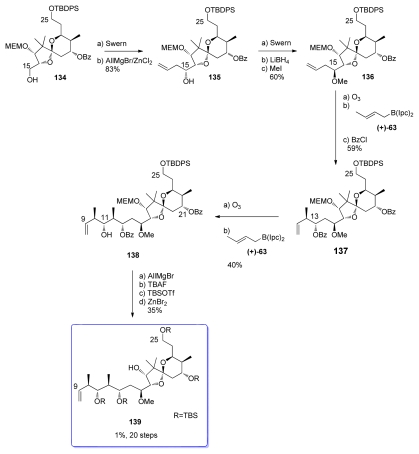
Preparation of 139.